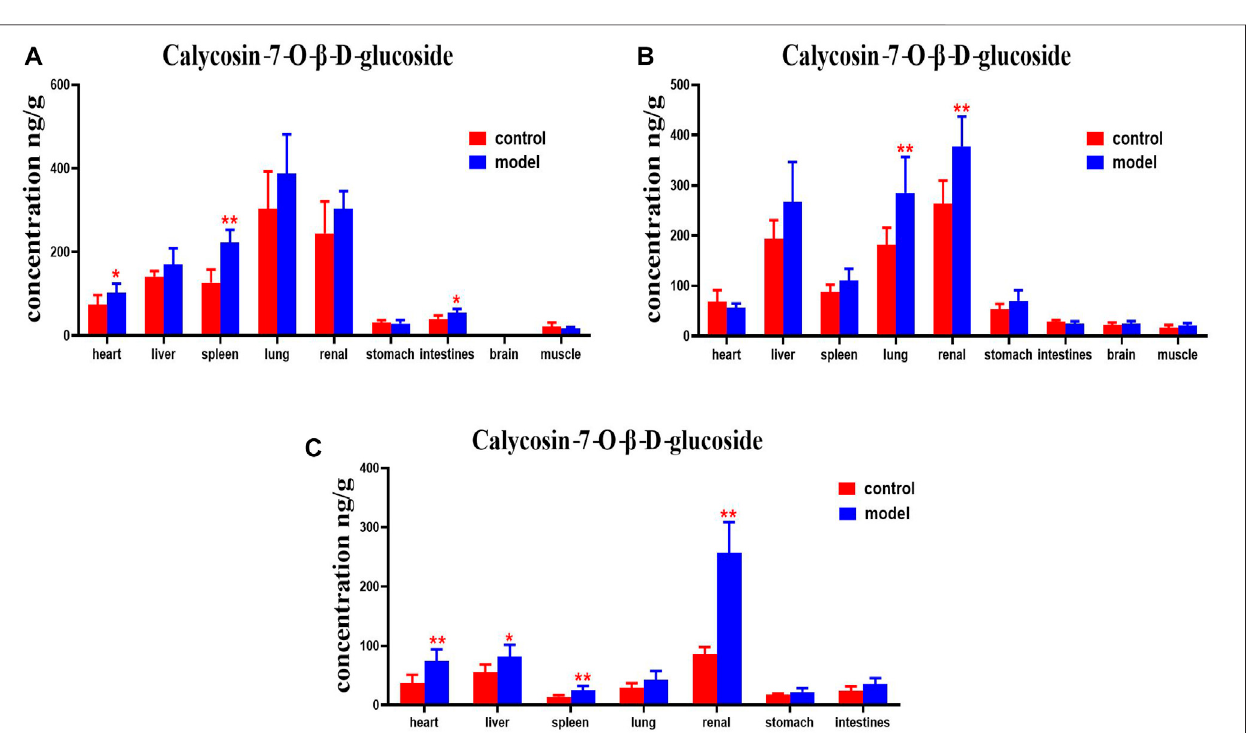
FIGURE 11 | Content of calycosin-7-O- β -D-glucoside in different mouse tissue homogenate of the normal and DN models at four different time points after intragastric administration of HQD (x±SD, n =8), (A) 30 min, (B) 2 h, (C) 4 h. Ps: * P < 0.05, ** P < 0.01 vs. normal group.